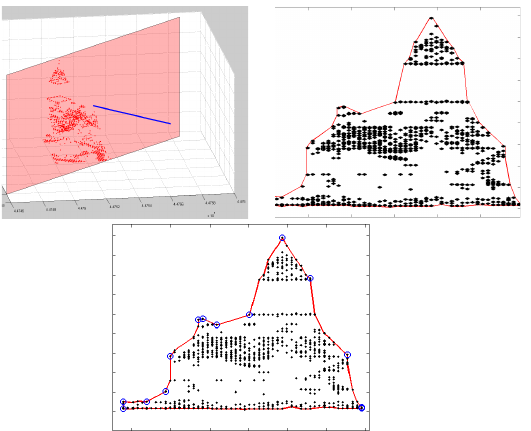
Figure 3: (a) LIDAR points of interest, virtual projection plane and its normal vector, (b) Projected LIDAR points and the ex- tracted alpha shape, (c) Detected LIDAR features.